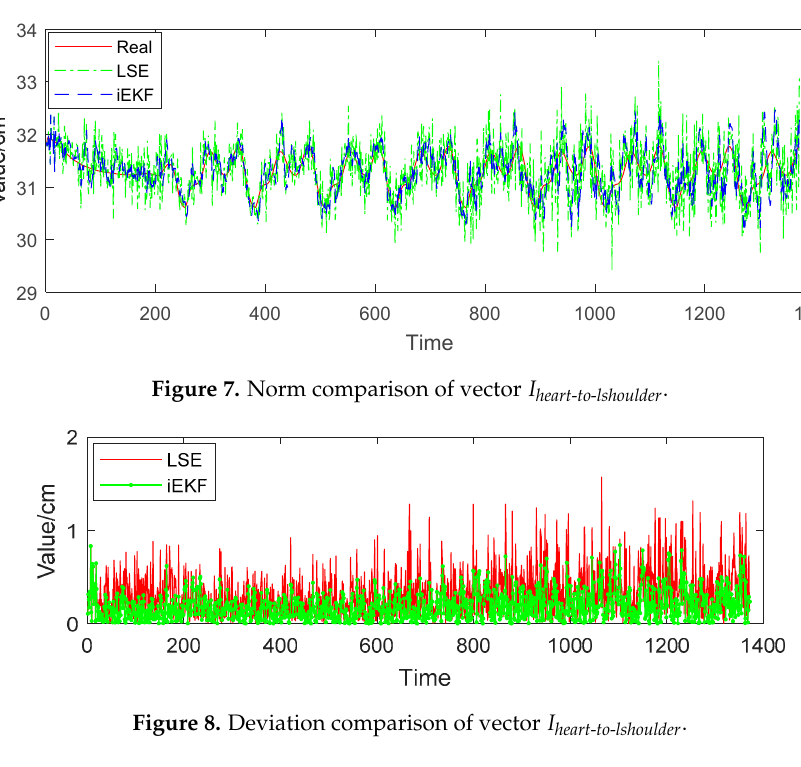
Figure 8. Deviation comparison of vector I heart - to - lshoulder